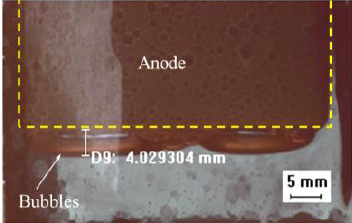
Figure 4. Measurement for the thickness of the bubble layer from side observations.